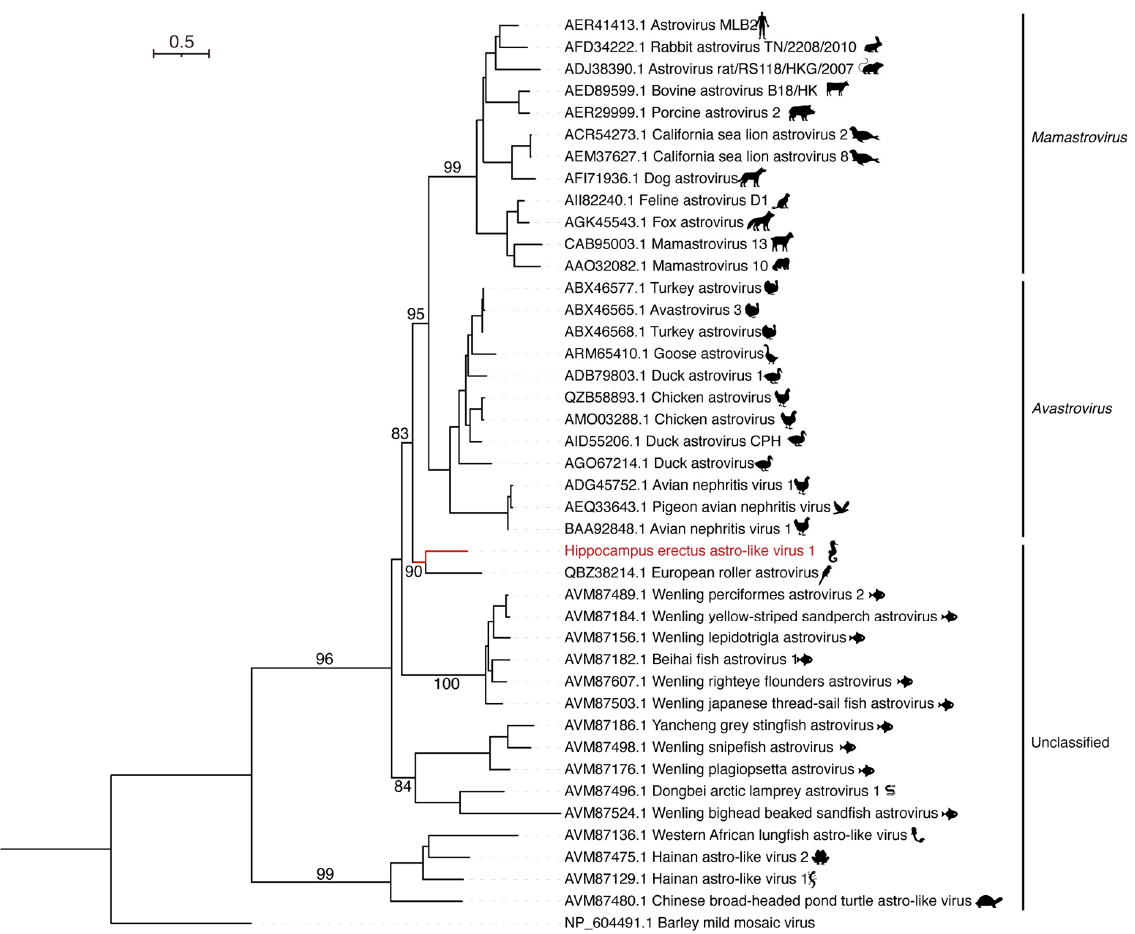
Figure 2. Phylogenetic analysis of the RdRp sequences of Hippocampus erectus astro-like virus 1 (HeAstV1) and representative astroviruses. The reference sequences were downloaded from GenBank and aligned using Mafft. Phylogenetic analysis was conducted using IQ-TREE, with the best-fit model LG + I + G4 and 1000 bootstrap replicates. Only bootstrap values >80% are shown.